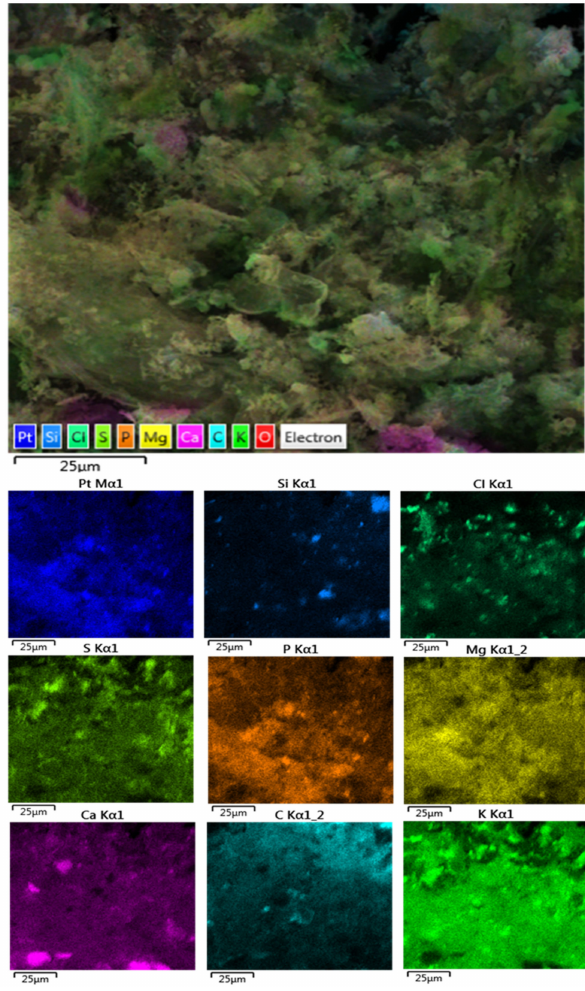
Figure 5. EDX mapping images of @PtCassCat.